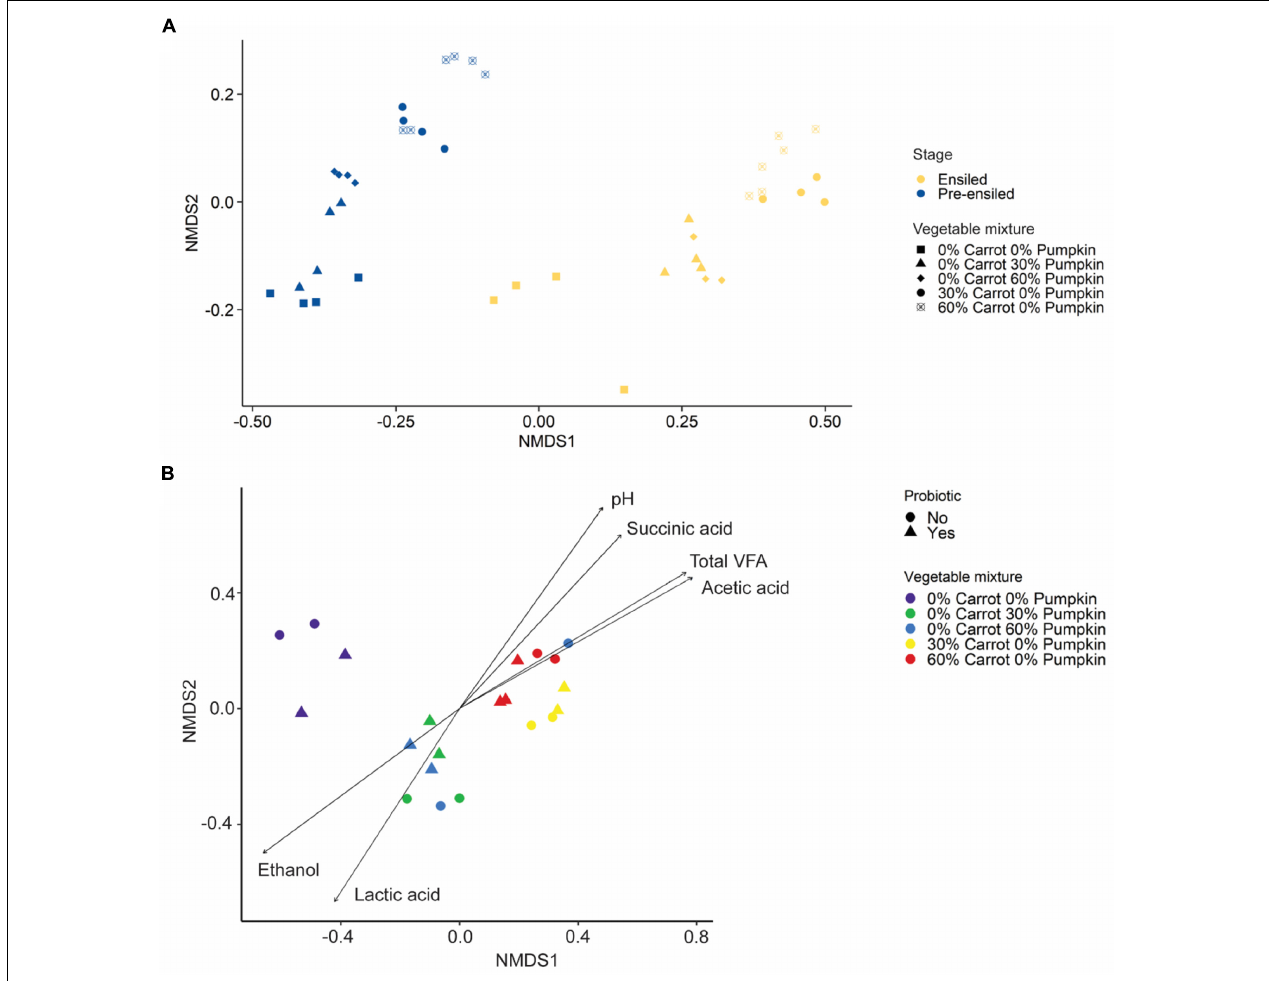
FIGURE 3 | (A) Non-metric multidimensional scaling analysis (NMDS) based on the Bray–Curtis distance measure of pre-ensiled and ensiled sorghum with carrot or pumpkin at 0, 30, or 60% DM. (B) Non-metric multidimensional scaling analysis (NMDS) based on the Bray–Curtis distance measure of sorghum ensiled with either carrot or pumpkin at 0, 30, or 60% DM, with or without a probiotic inoculant. In (B) , vectors having a statistically significant association ( P < 0.05) with the ordinations are included. Vector length is proportional to the degree of correlation between the fermentation parameters and the